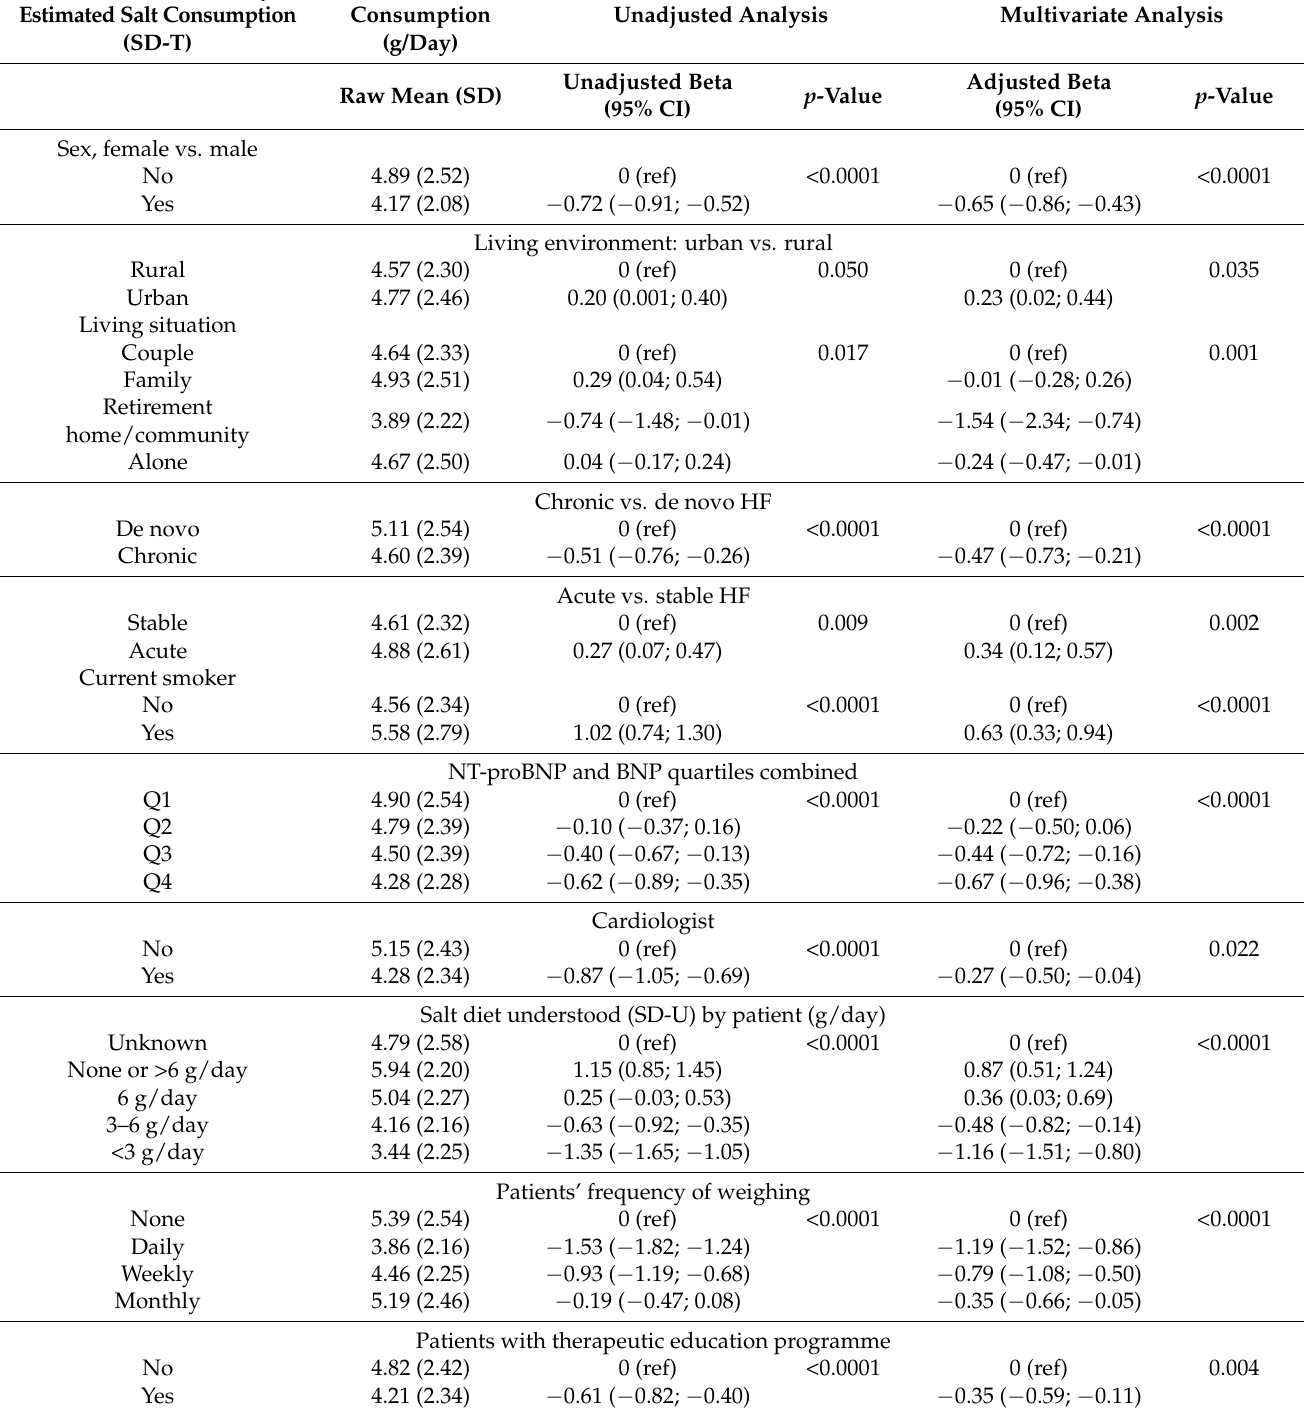
Table 4. Determinants of daily estimated salt consumption (SD-T): results from univariate and multivariate linear regression